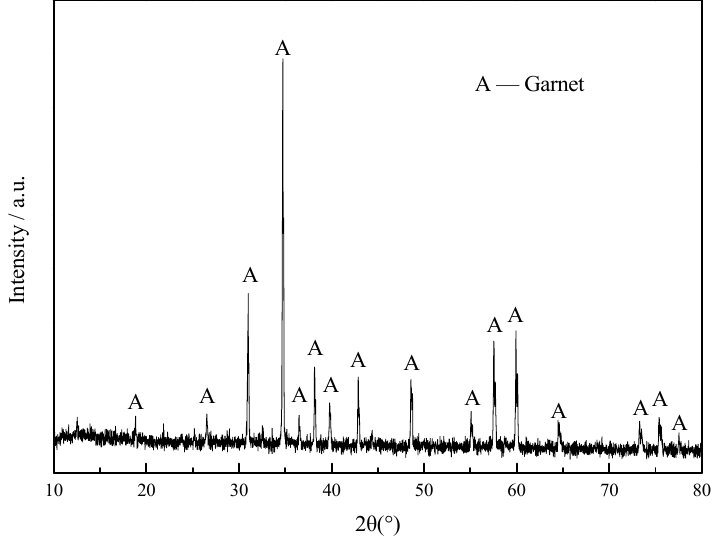
Figure 1. XRD pattern of garnet.